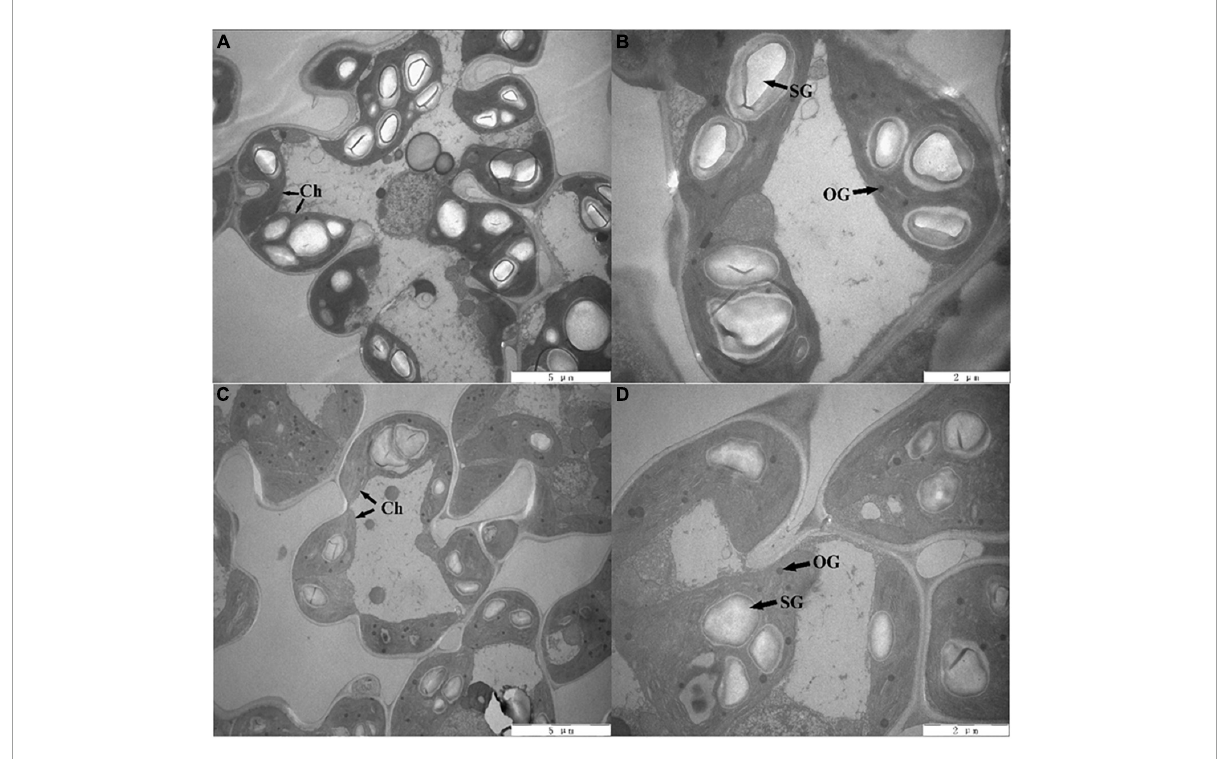
FIGURE1 Chloroplast ultrastructure of rice leaves. Panels (A,B) represent no straw return (S0), panels (C,D) represent rice straw return (SR). Ch, chloroplast; OG, osmiophilic globules; SG, starch grains, (A,C) scale bar = 5 µ m; (B,D) scale bar = 2 µ